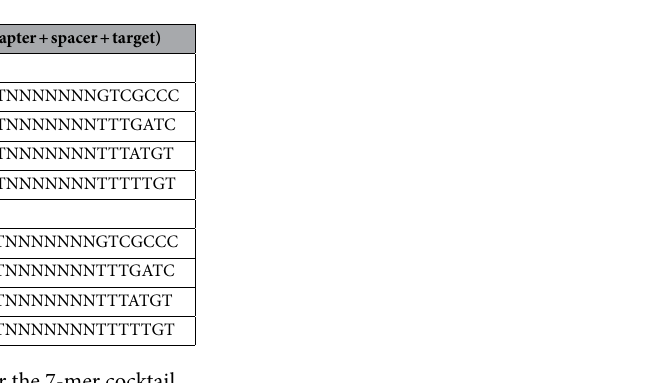
Figure 2. Sequencing performance of the developed primers. ( a ): Representative example of electrophoresis of each primer set (The white line represented cropped region to exclude the empty lanes, original uncropped gel image is presented in Supplementary information in Fig. S4); ( b ): The sequenced bases per read by Miseq output; ( c ): Relationship between read number and total sequenced bases obtained using 7-mer and MIG-seq cocktails. ( d ): Reduction curve of commonly sequenced bases among randomly selected individuals of O. latipes .